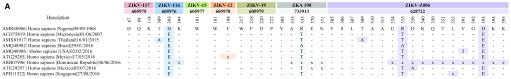
B-cell epitopes alignments mapped with human anti-E monoclonal antibodies.A total of 9 Zika strains are variable at predefined B-cell epitopes during 1968–2017.